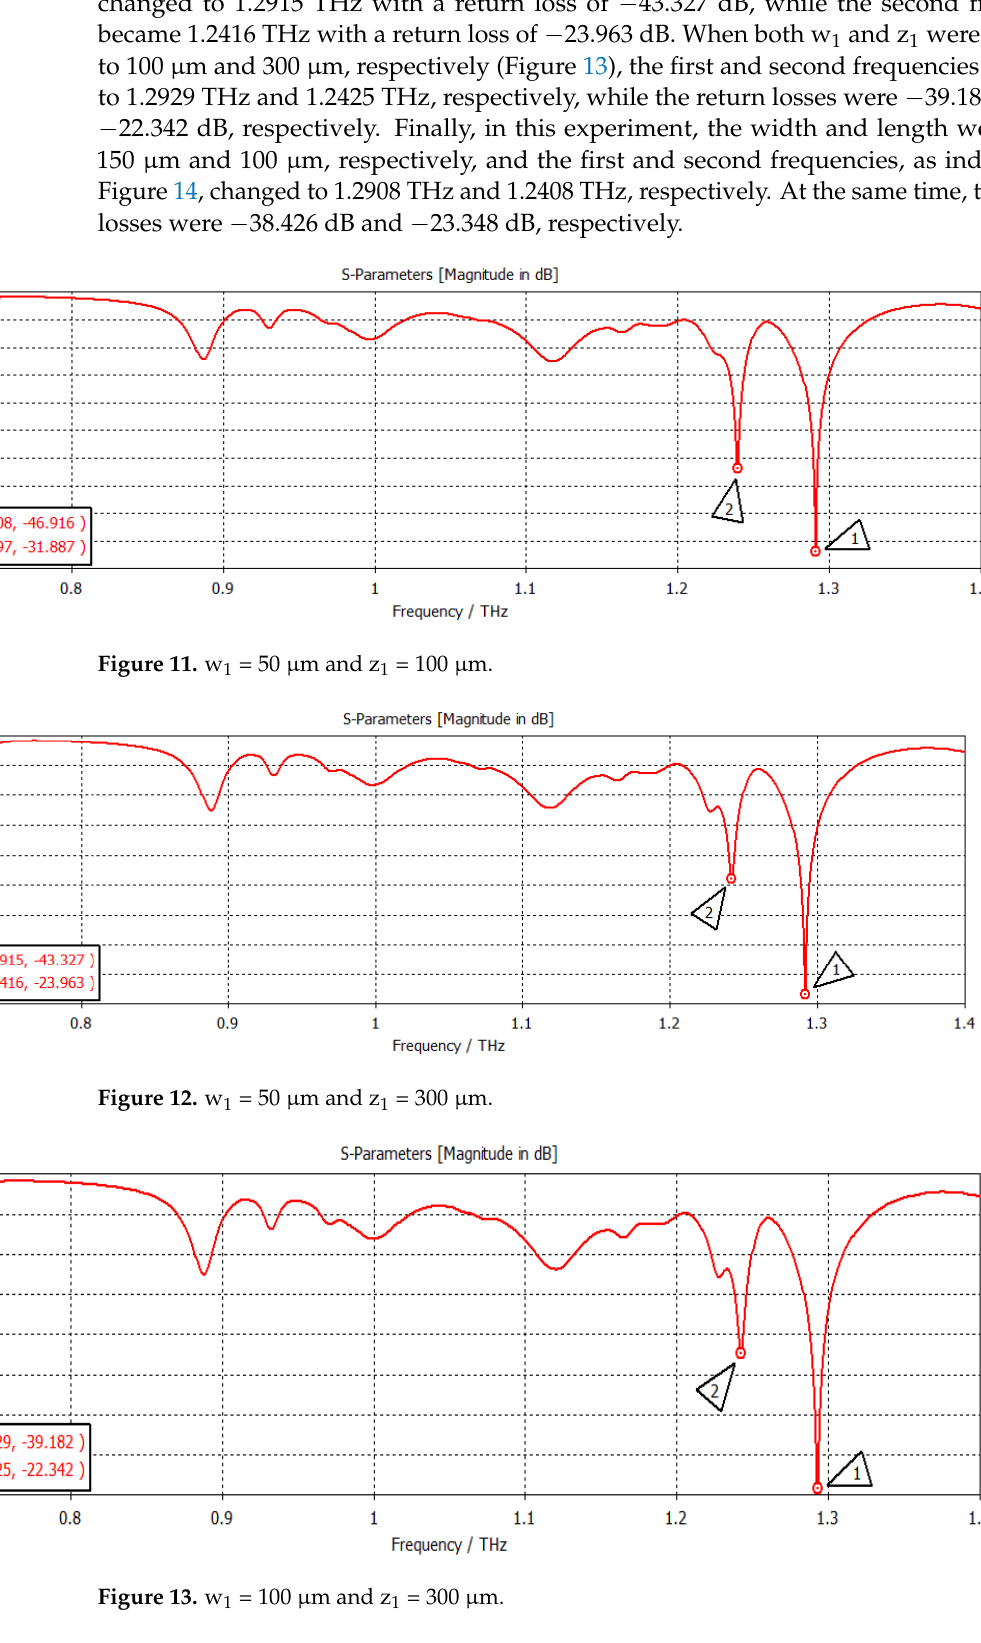
Figure 14. w 1 = 150 µm and z 1 = 100 µm. From Table 3, where this work is compared with similar work using graphene as a tuning element, it can be seen that the filter operated at a higher frequency than filters and antennas designed using planar technology. The tunable bandwidth of the filter devel- oped herewith, 1.289−1.297, was high, making it suitable for the tunability of various and broader application prospects.